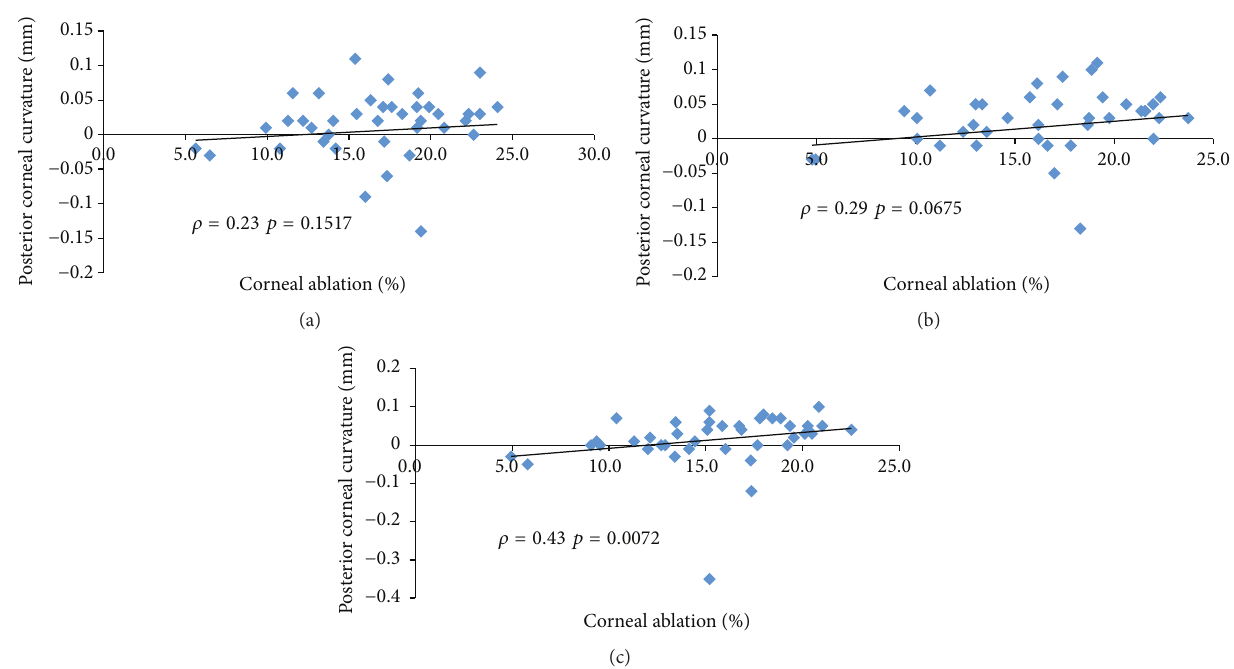
Figure 3: Spearman’s coefficient of rank correlation ( 𝜌 ) between percentage of corneal ablation and changes in posterior corneal curvature (mm) at 1 month (a), 6 months (b), and one year